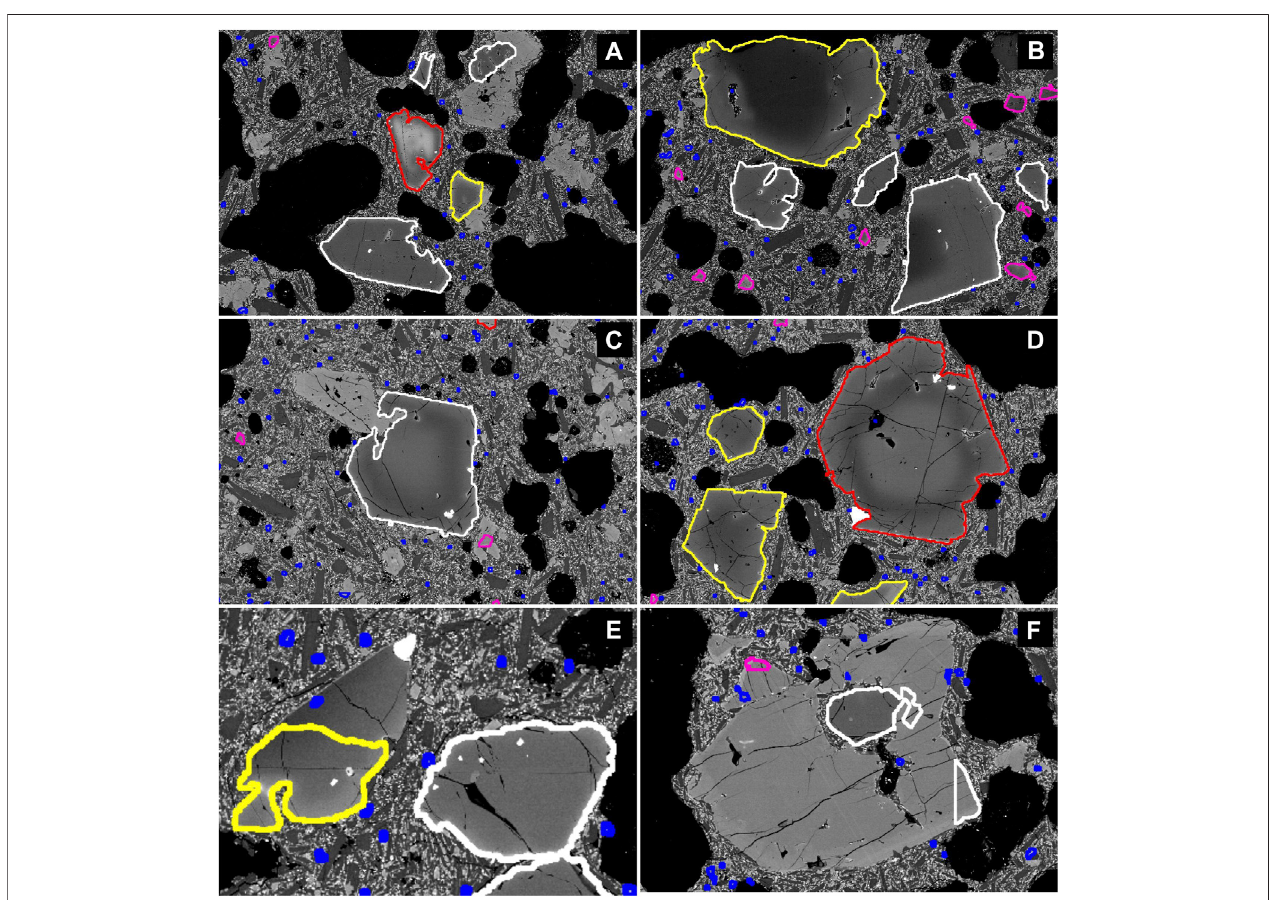
FIGURE 10 | Examples of successful (A) and failed automated phenocryst classi fi cation (B – D) and olivine DL segmentation (E – F) . (A) successful classi fi cation of the “ normal ” (yellow), “ reversed ” (red) and “ no zoning ” (white) patterns. The overwhelming majority of the phenocrysts is correctly classi fi ed (see full thin section image with segmented olivines here); (B) Two large olivine phenocrysts with normal zoning are classi fi ed as “ normal ” (correct) and “ no zoning ” (incorrect). The phenocryst with incorrectly recognized zoning pattern in (E) represent a broken fragment (yellow) of a larger crystal; (C) and (D) demonstrate two incorrect cases of classi fi cation into “ nozoning ” (C) andreversed (D) groupsforcrystalswithmorecomplexzoningpatternwithironrichcoreandrimandmoremagnesianmantle; (E) olivinephenocryst with normal zoning (yellow) which was only partly recognized as olivine; (F) clinopyroxene phenocryst with areas incorrectly segmented as olivine (small inclusions and triangle-shaped area). See text for